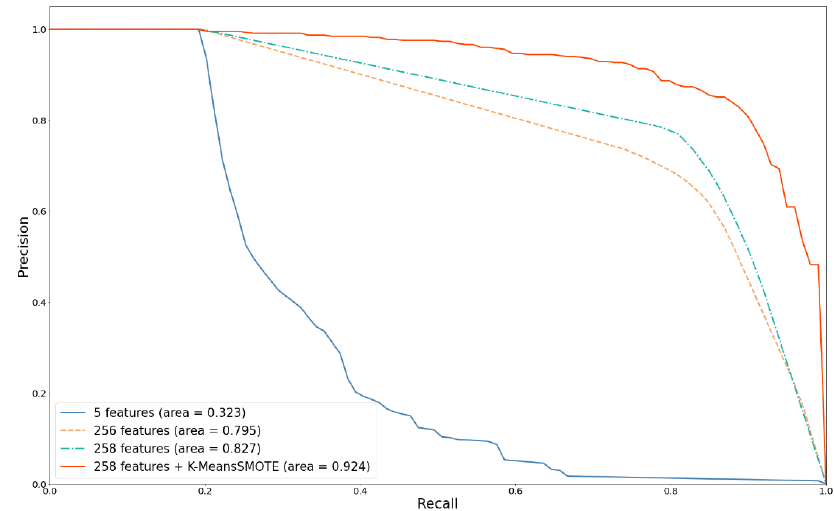
Figure 9. Comparison of PR curves with different feature extractors.